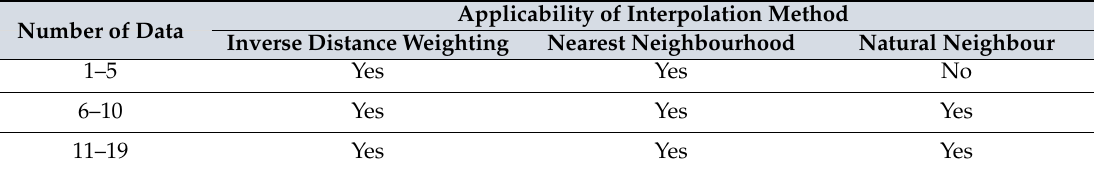
Table 4. Recommended interpolation methods for small input data set